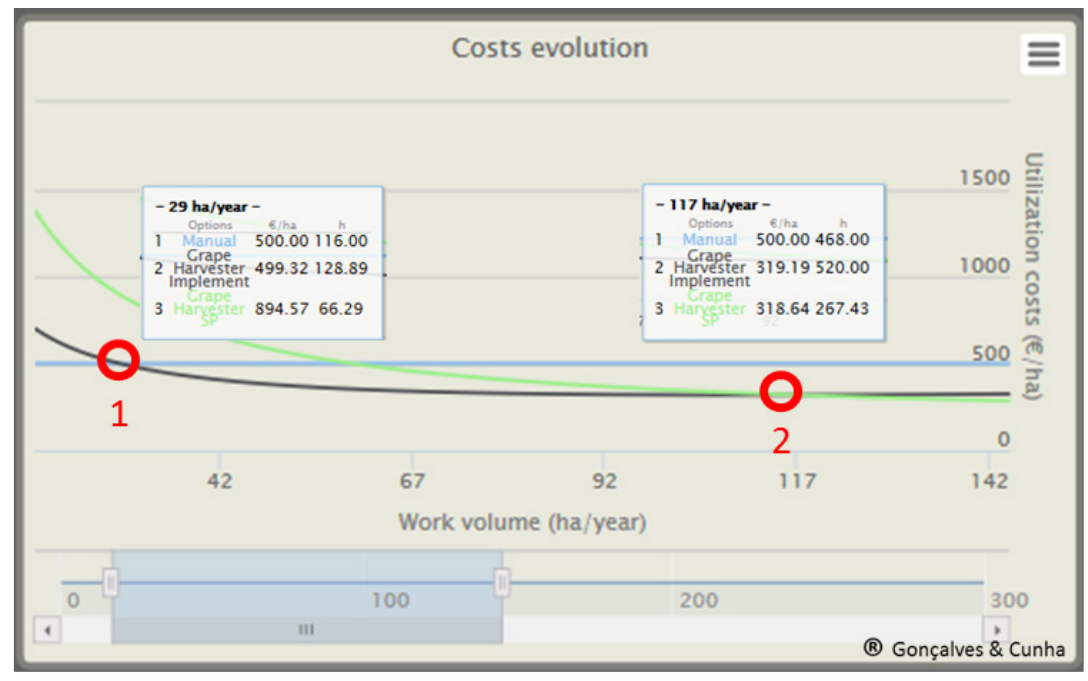
Figure 7: MACHoice’s screen-shot (zoomed-in and altered) for the impact of work volume on the total costs. The blue series represents the manual option, the black expresses the grape harvest implement and the green exhibits the self-propelled harvest. Points 1 and 2 in red represent the break-even points for GHI and SP